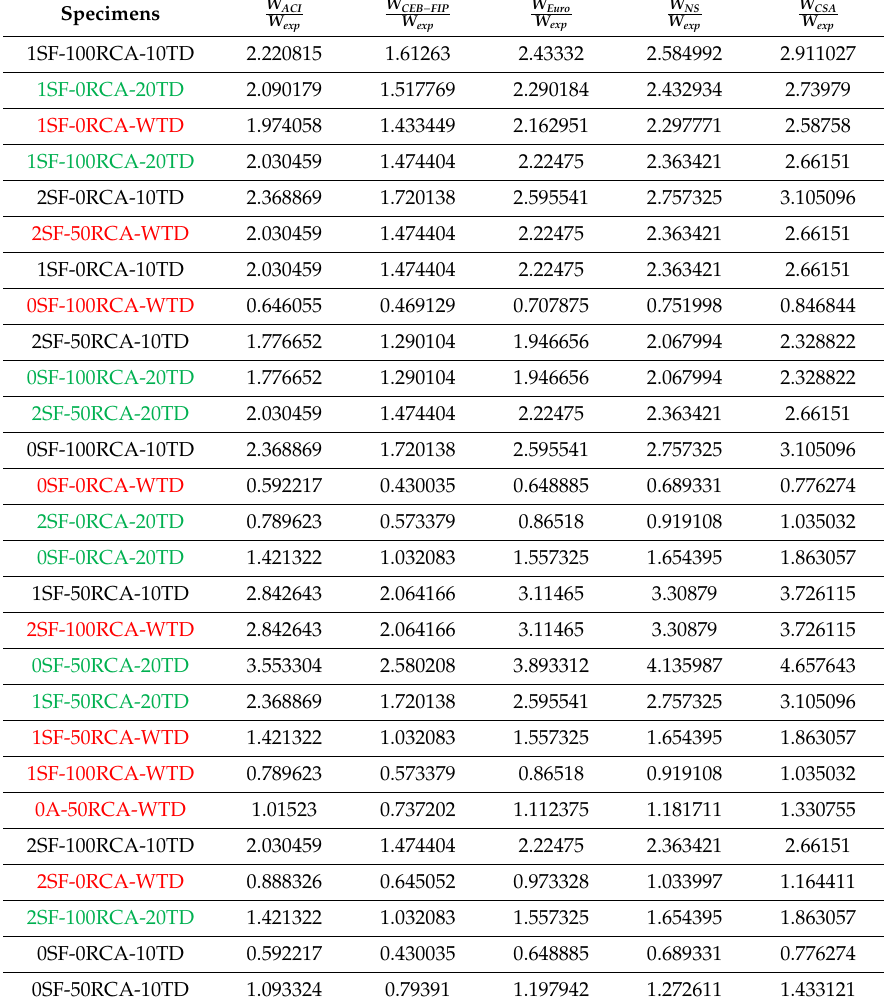
Figure 24. Observed versus predicted ultimate crack width of specimens with a 100 mm shear rebar spacing. Table 7. Comparison between the numerical and experimental results of the crack widths.